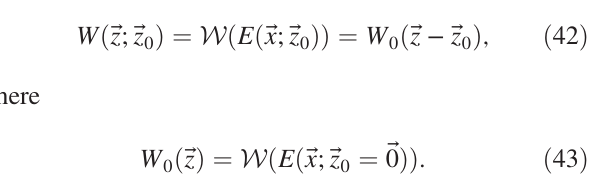
FIG. 6. Comparison of analytically and numerically calculated spatial projections of drifted WFDs for m ¼ 3 .